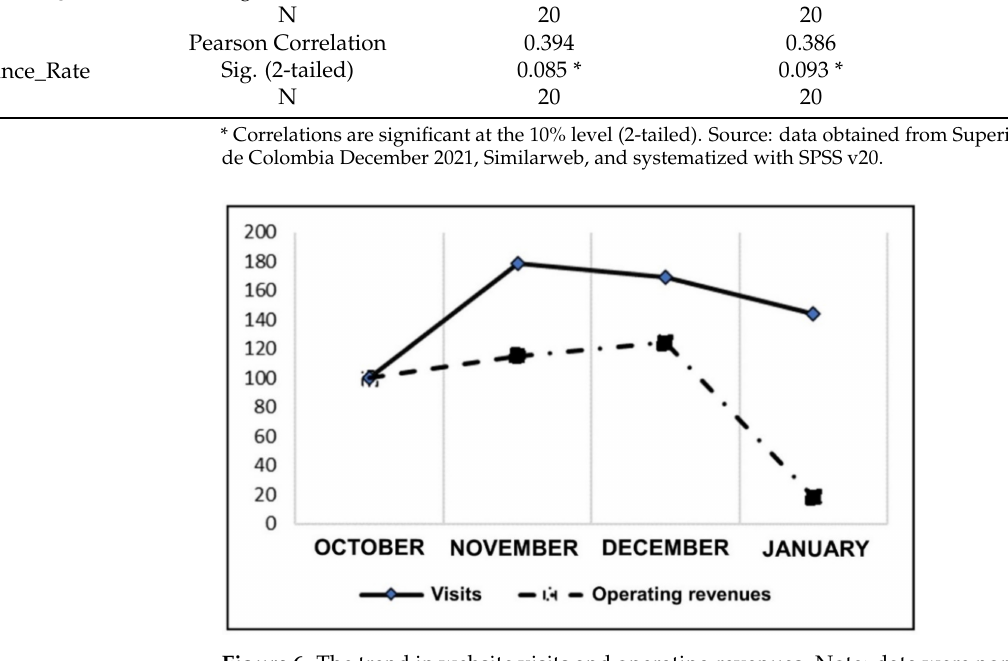
Figure 6. The trend in website visits and operating revenues. Note: data were normalized on a base of 100, where the initial value is the number of unique visitors and operating revenues for October